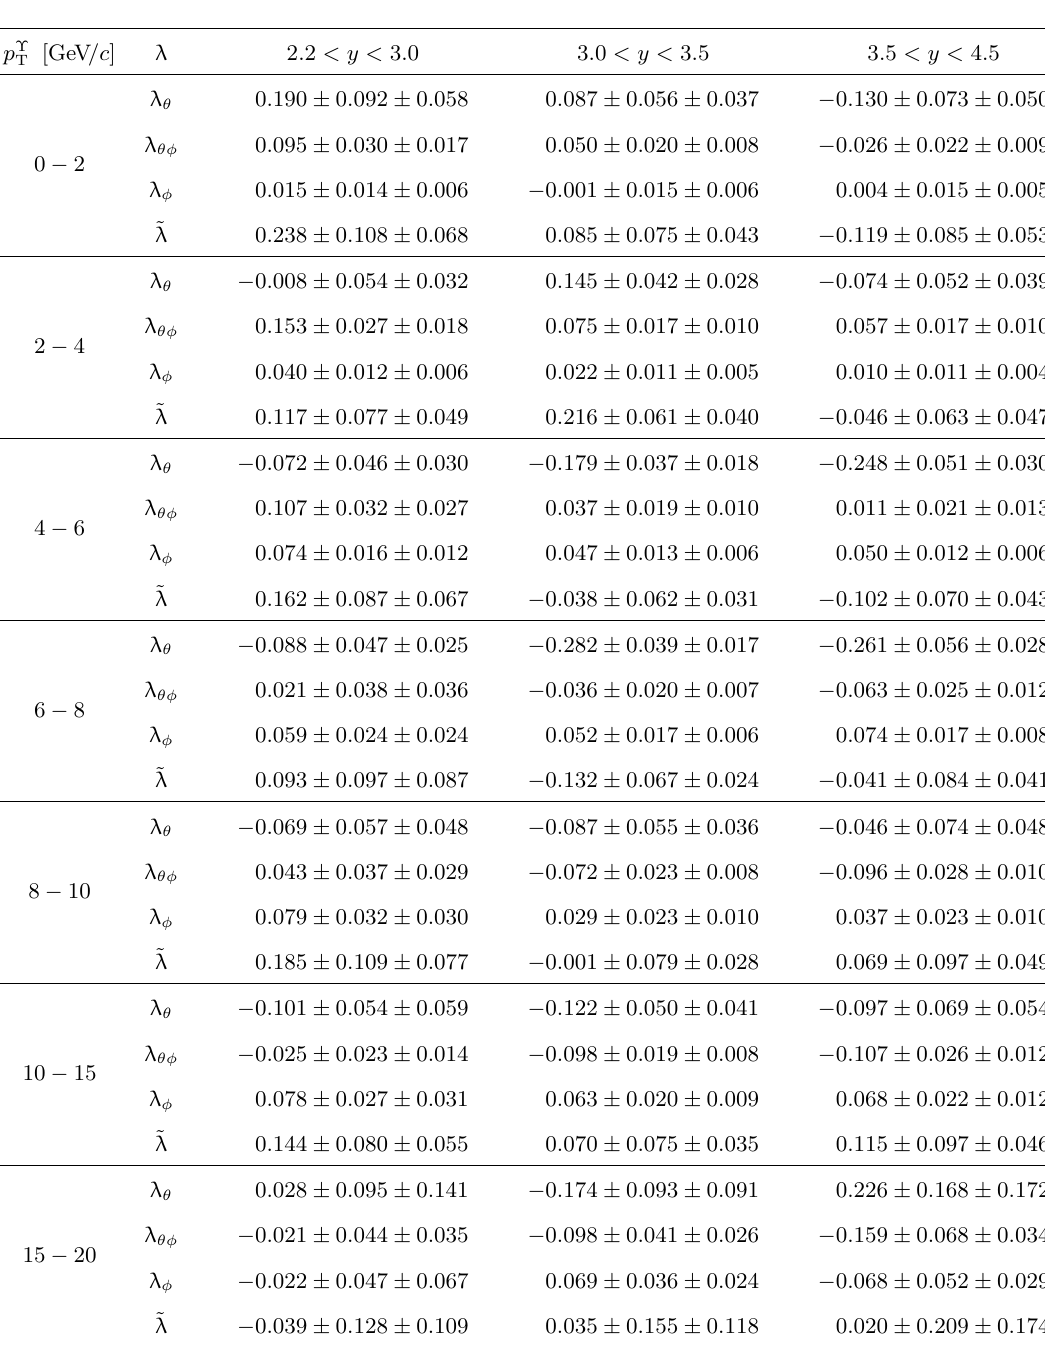
Table 16 . Values of (cid:21) (cid:18) , (cid:21) (cid:18)(cid:30) , (cid:21) (cid:30) and ~ (cid:21) measured in the GJ frame for the (cid:7)(2S) produced at p s = 8 TeV. The (cid:12)rst uncertainty is statistical and the second systematic.